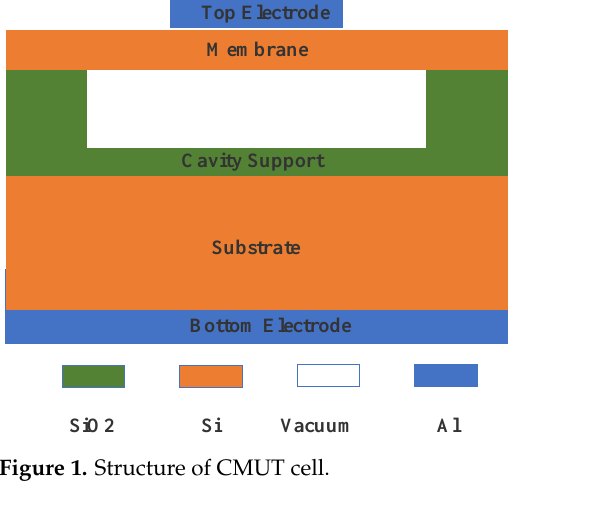
Figure 1. Structure of CMUT cell.